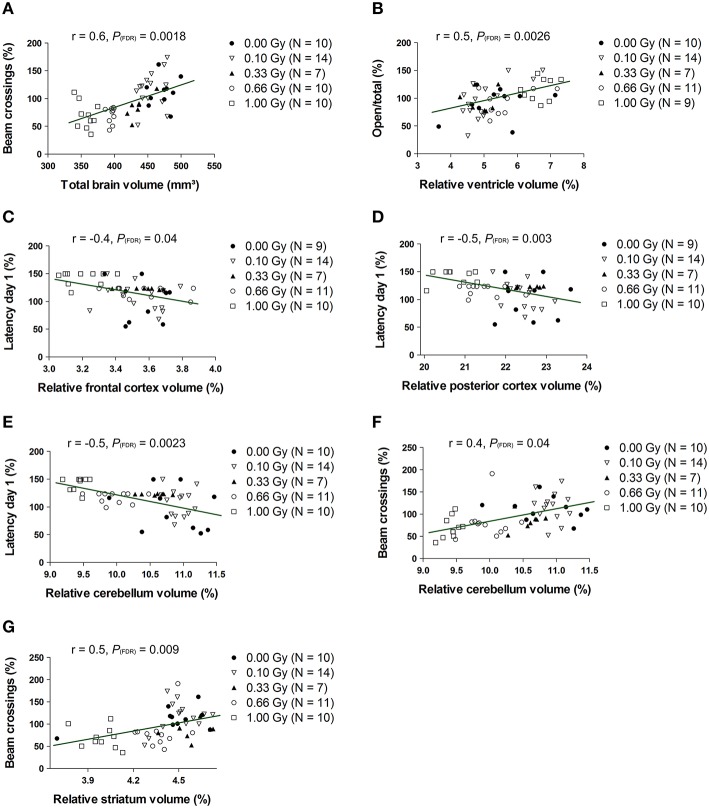
The whole-brain volume, along with the normalized volumes of the ventricles, frontal and posterior cerebral cortex, cerebellum and striatum, correlate significantly with altered behavioral outcome. Statistically significant correlations were found between the total brain volume and number of beam crossings in the cage activity (A) and between the normalized ventricle volume and the number of open/total (B) and open/closed (not shown) arm entries in the elevated plus maze. Furthermore, we discovered correlative relationships between the normalized frontal cortex volume and MWM latency (C), between the normalized posterior cortical volume and MWM latency (D), between the normalized cerebellar volume and MWM latency (E), between the normalized cerebellar volume and cage activity beam crossings (F) and between the normalized striatal volume and cage activity beam crossing (G). Correlation coefficients (r) and P values are indicated for each correlation. The number of animals used is indicated in the legend (N). FDR, False discovery rate; Gy, Gray; MWM, Morris water maze; SPSN, Sociability and preference for social novelty.